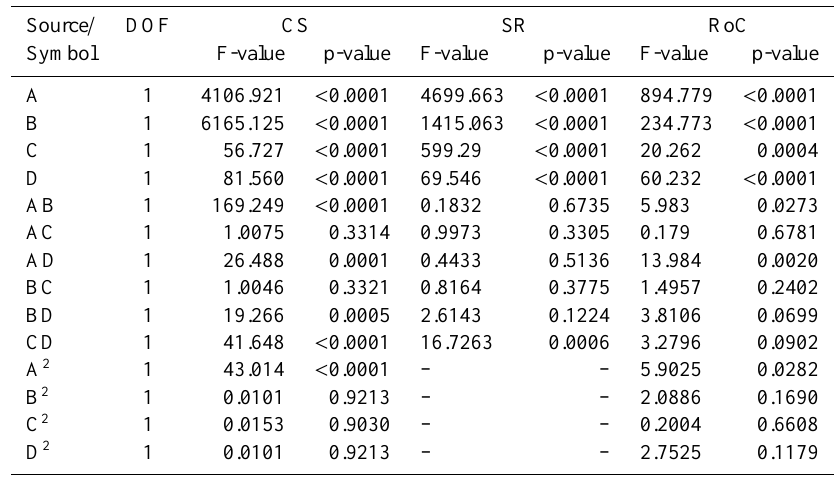
Table 4. F-value and p-value for each model term for CS, SR and RoC. Source / DOF CS SR RoC Symbol F-value